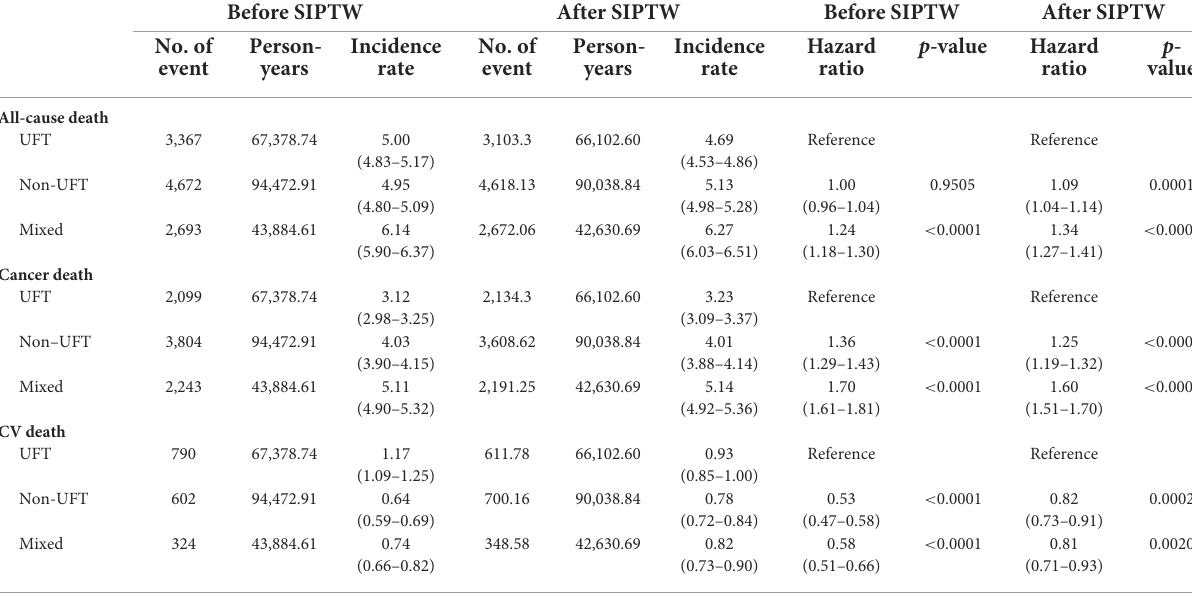
TABLE 3 Mortality among patients with stage II–III colorectal cancer before and after SIPTW.